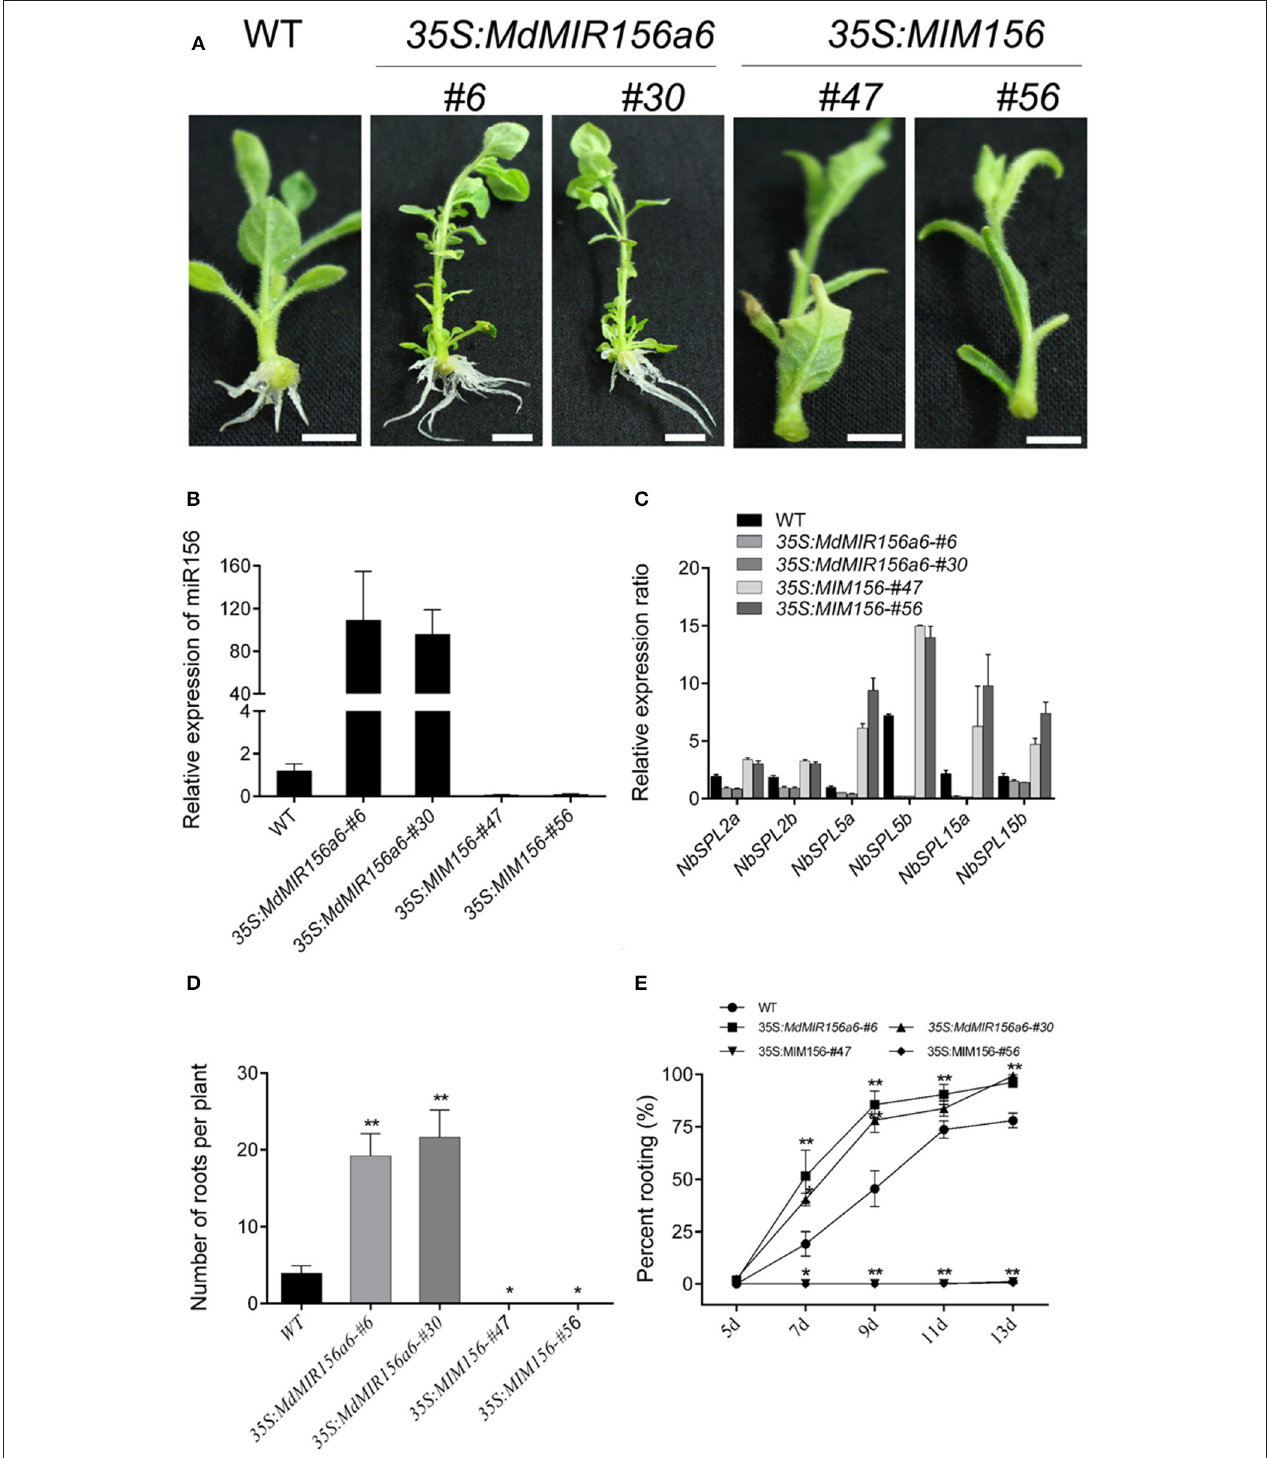
FIGURE 3 | MiR156 affects adventitious rooting capacity in transgenic tobacco plants. (A) Phenotypes of 13-day-old plants (wild-type, 35S:MdMIR156a6, and 35S:MIM156 ) grown on hormone-free MS medium. Scale bars = 20 mm. (B) Relative expression level of miR156 in transgenic tobacco lines. Bars show SD from three biological replicates. (C) Relative expression levels of NbSPLs in WT, 35S:MdMIR156a6, and 35S:MIM156 plants in stems. (D,E) Rooting ability of tobacco stem cuttings. (D) Adventitious root number per cutting and (E) percent rooting. Adventitious root number was counted after 13 days of growth on MS medium. Bars show SD from three biological replicates; n = 10 in individuals per replicate. Asterisks indicate significant differences from the WT (Student’s t -test, ** P < 0.01, * P < 0.05).